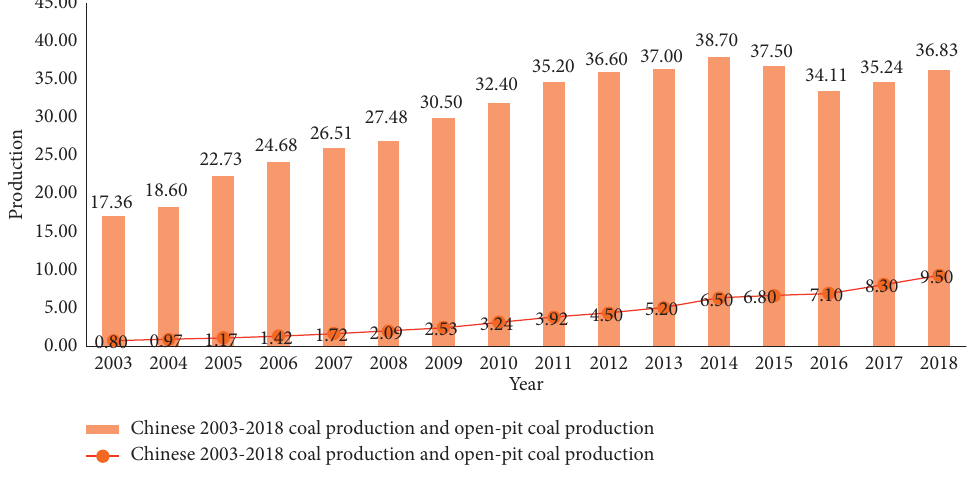
Figure 1: China 2003–2018 coal production and open-pit coal